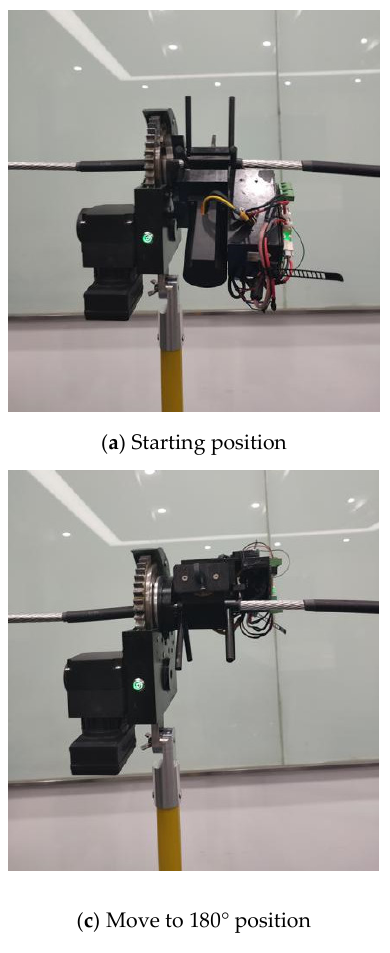
Figure 8. Stripping process of the